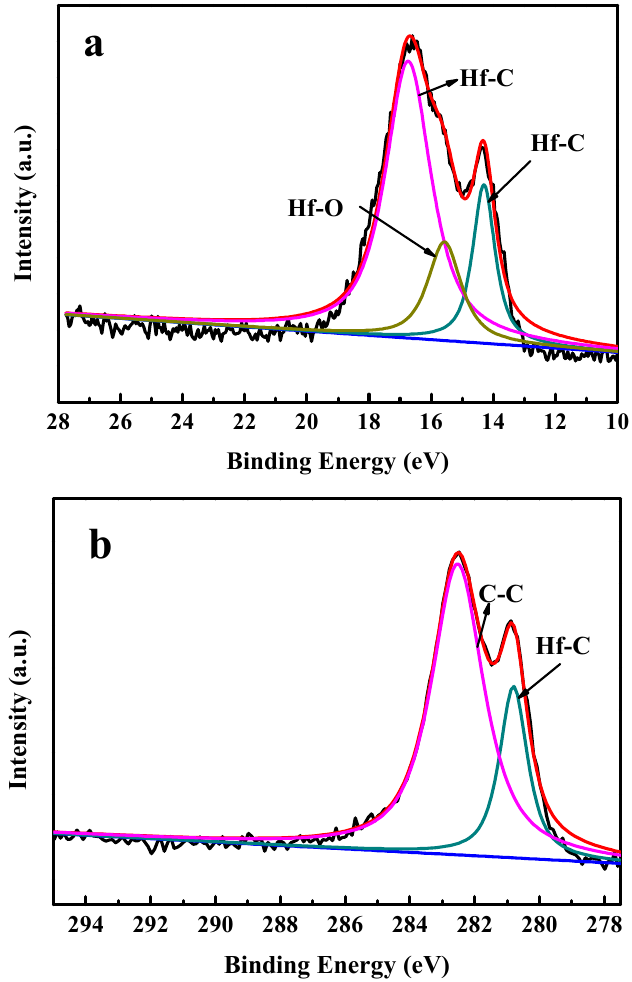
Figure 3. XPS spectra of HfC coating deposited at a bias voltage of − 200 V: ( a ) Hf4f and ( b ) C1s.